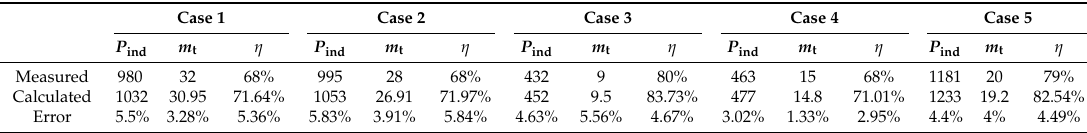
Table 3. Comparison of measured and calculated